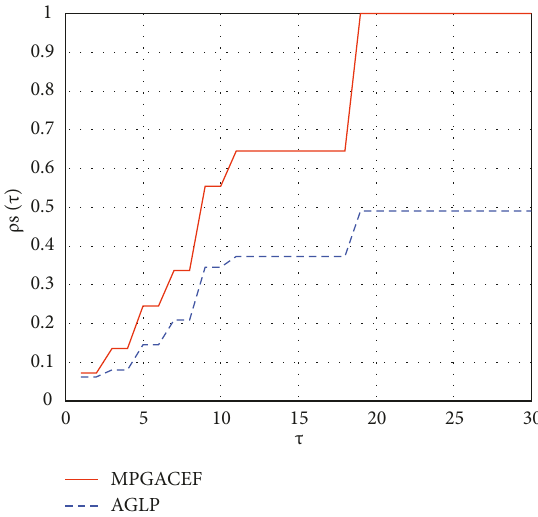
Figure 4: Performance of CPU Time for MPGACEF and AGLP under the condition of TSP50.